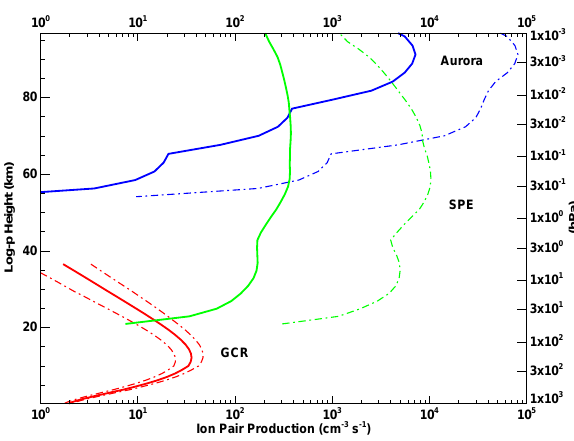
Fig. 3. Vertical pressure profiles of the time mean ion pair production rate for auroral zone electrons (blue), SPEs (green), and GCR (red). The time average for SPEs is done only for the fraction of the time when ionization exceeds 100 pairs cm − 3 s − 1 at some altitude. The dash-dot curves represent maximum and minimum ionization for the 1979 through 2006 period. Minimum ionization is signifi- cant only for